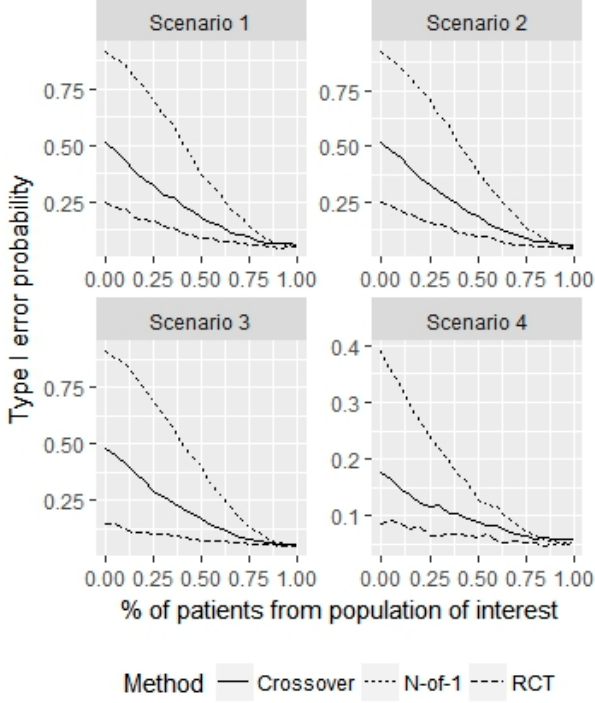
Figure 5. Simulation study for non-representative sample of size 30. This figure displays the probability of making a false discovery (i.e., type I error) for the population as a function of misrepresentation proportions.